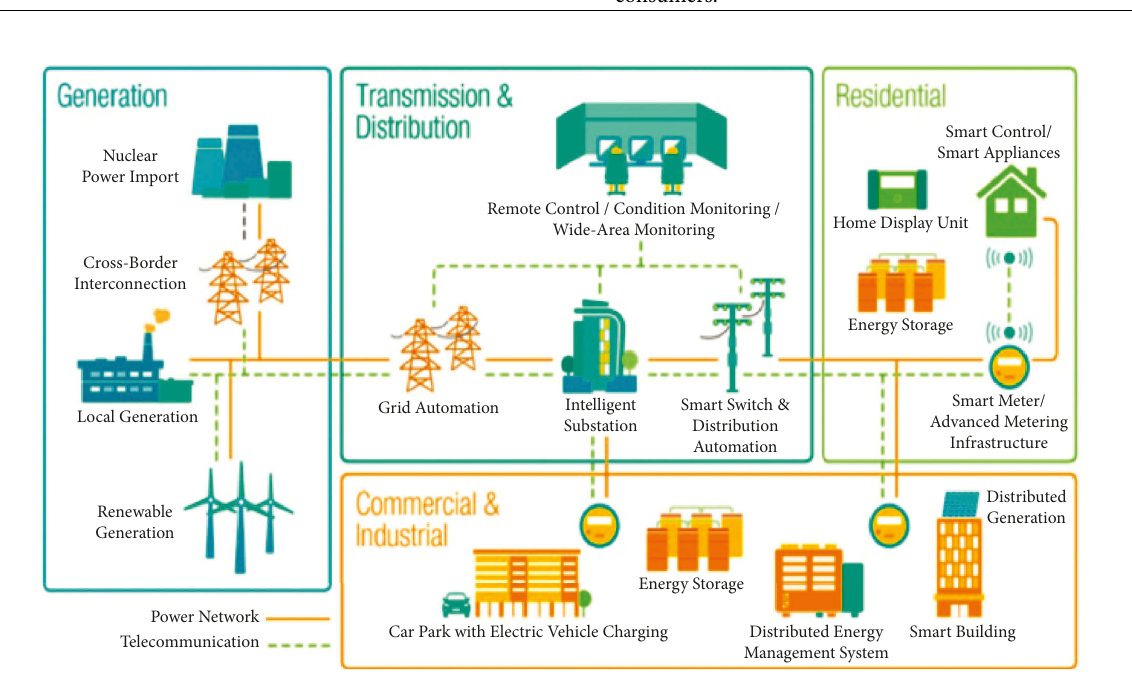
Figure 2: The smart grid concept. It can generate electricity from a variety of sources that are widely scattered, such as wind turbines, solar power systems, and plug-in hybrid electric vehicles. It employs digital automation technology for supply chain monitoring, control, and analysis [21].